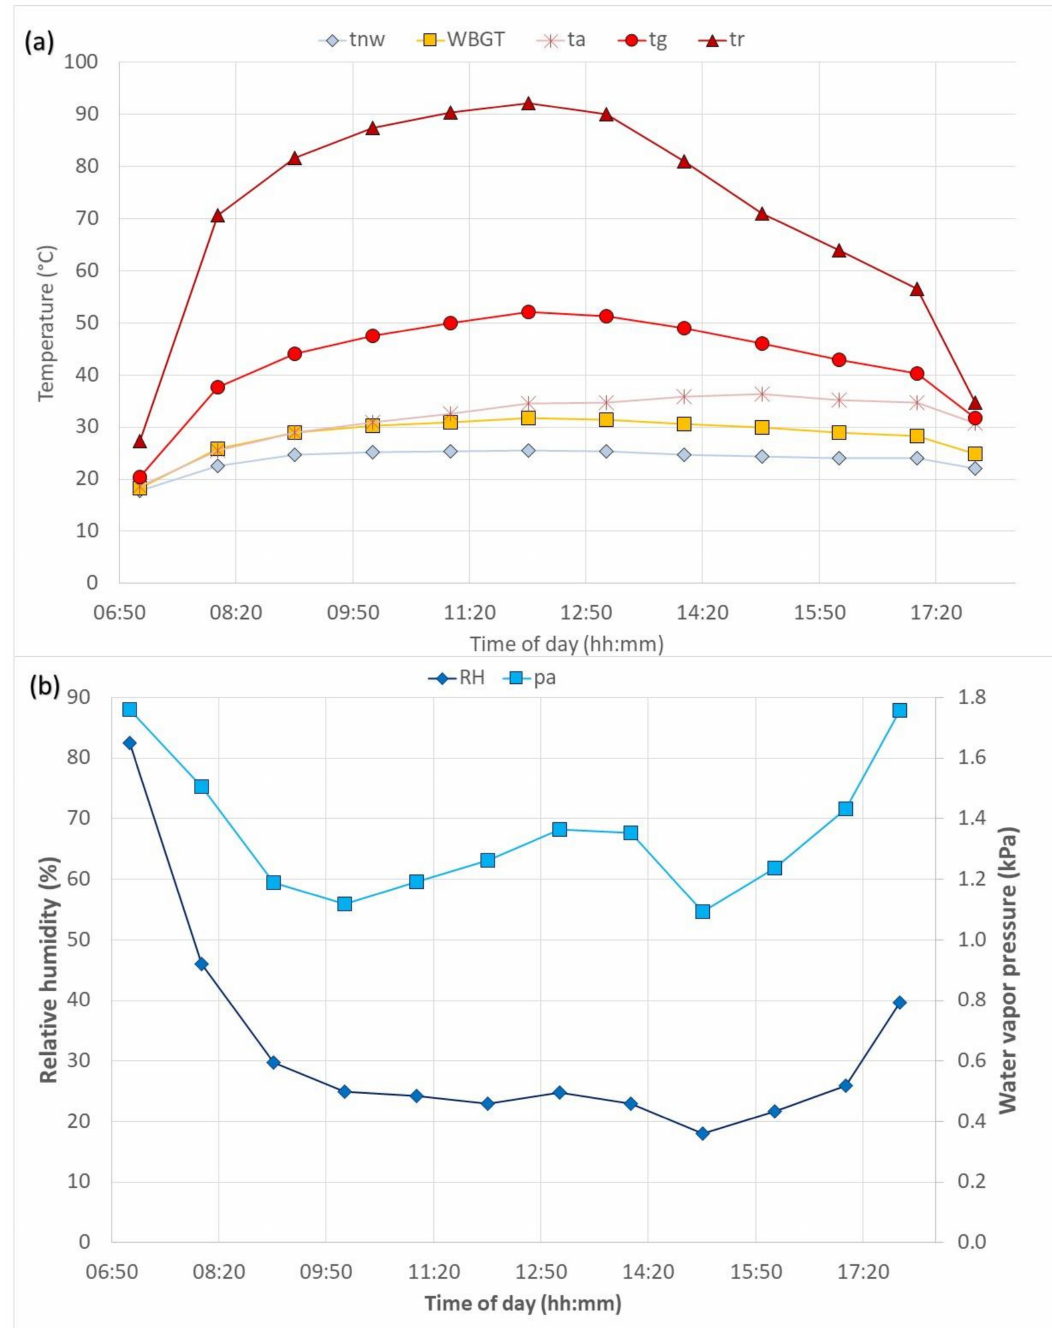
Figure 2. Environmental parameters for one day (14 January 2015) in a sugarcane field in Nicaragua. ( a ) Temperatures ( ◦ C): t nw —natural wet bulb temperature, WBGT—wet bulb globe temperature index; t a —air temperature, t g —temperature of a globe thermometer and t r —mean radiant temperature; ( b ) humidity: RH—relative humidity (%) and p a —absolute humidity expressed as water vapor